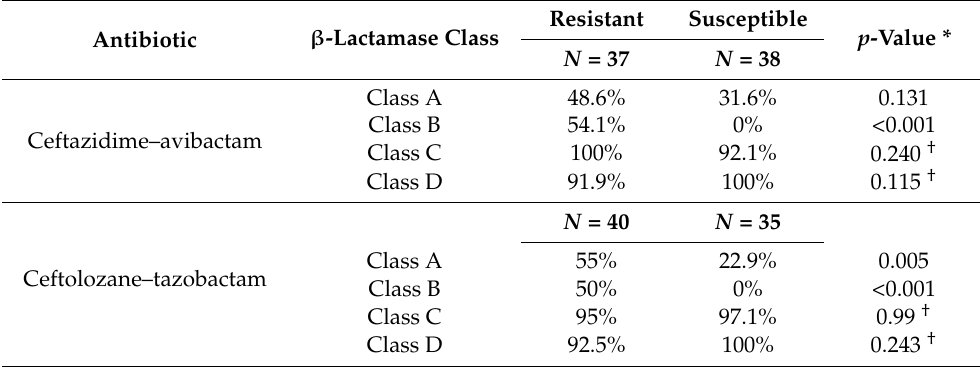
Table 2. The frequency of association between different β -lactamase classes and resistance